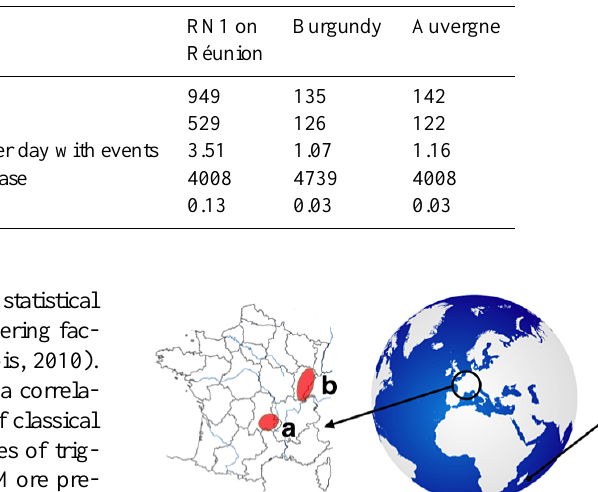
Table 1. Principal characteristics of the three databases.